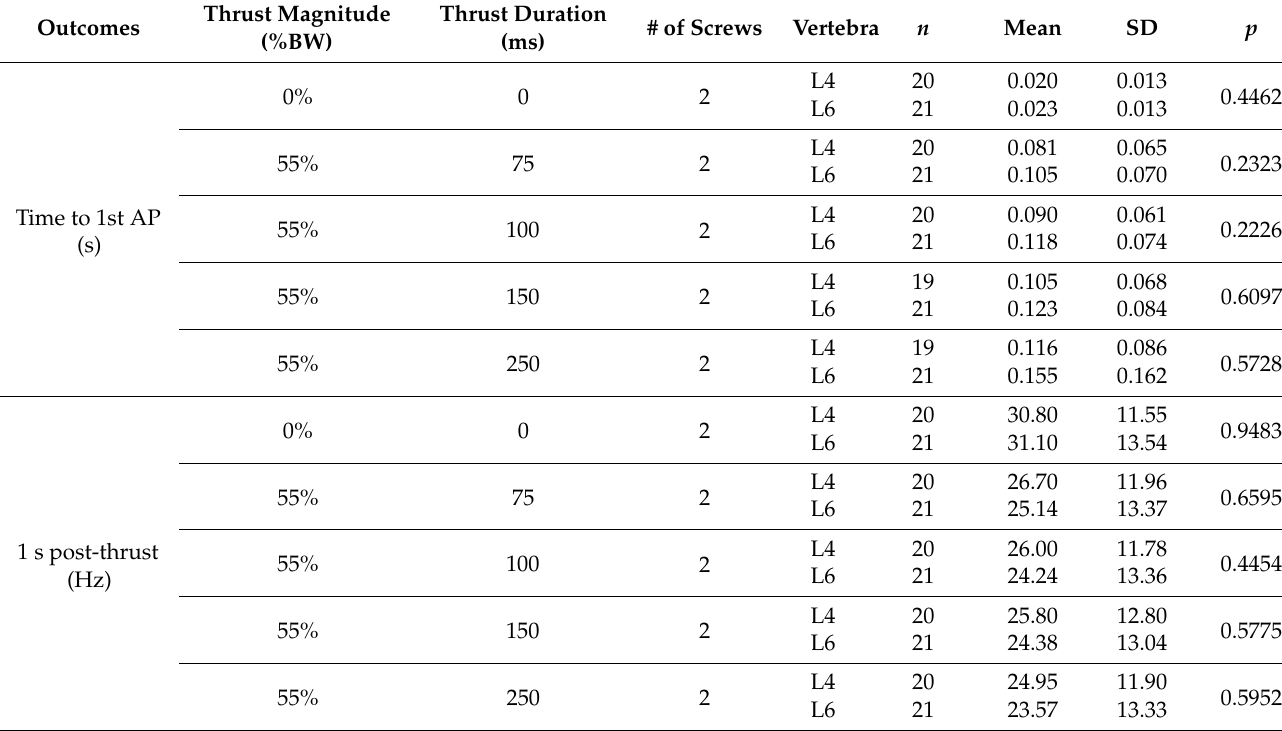
Table 2. Thrust Duration Comparisons Between L4 and L6